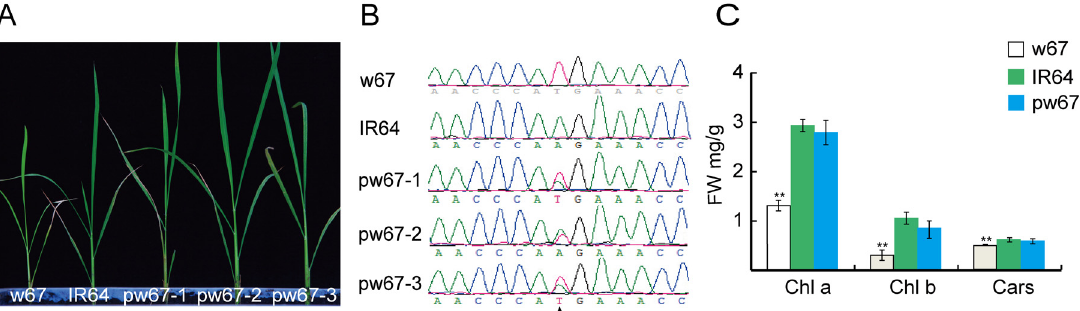
Fig 4. Functional complementation at the w67 allele. A, Phenotypes of w67, IR64 (WT) and complemented plants (pw67-1, pw67-2 and pw67-3); B, Nucleotides at the mutation sites in w67, IR64 and complemented plants; C, Levels of Chl a, Chl b and Cars in w67, IR64 and complemented plants at 8-week old. ** , Highly significance at P (cid:2)